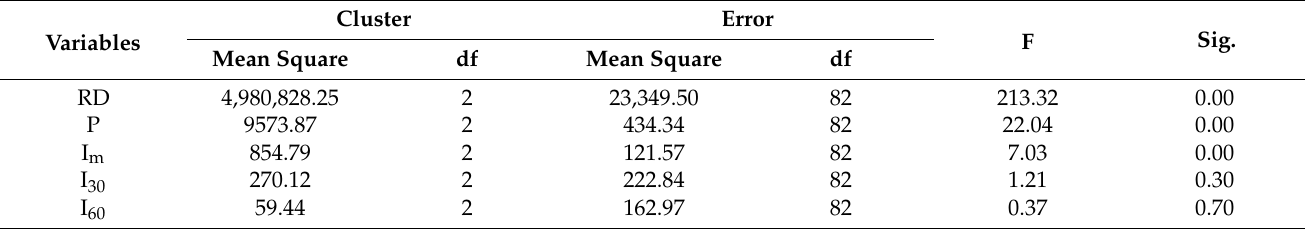
Table 3. One-way analysis of variance (ANOVA) results using a K-means clustering classification method. Variables